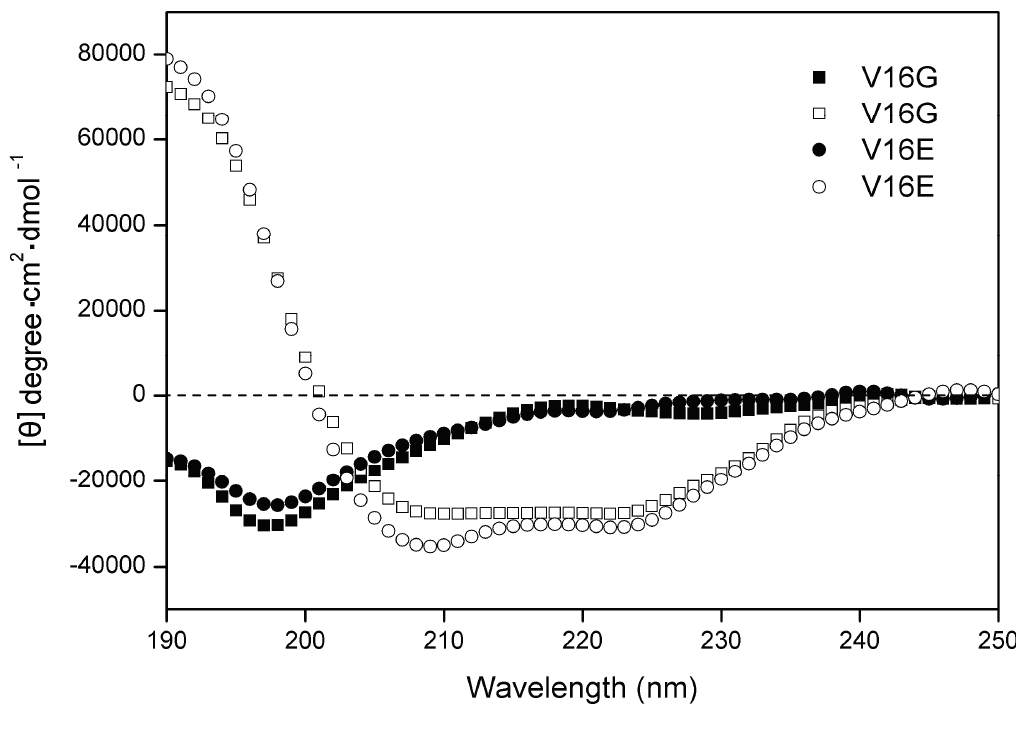
Figure 2. CD spectra of peptide V16G and V16E at pH 7 and 25 °C in 50 mM KH PO /K HPO containing 100 mM KCl. Solid symbols denote the CD spectra of 2 4 2 4 peptide analogs in KP buffer without TFE, and open symbols denote CD spectra obtained in the presence of 50% TFE. Peptide V16G data are presented by squares and V16E by circles.